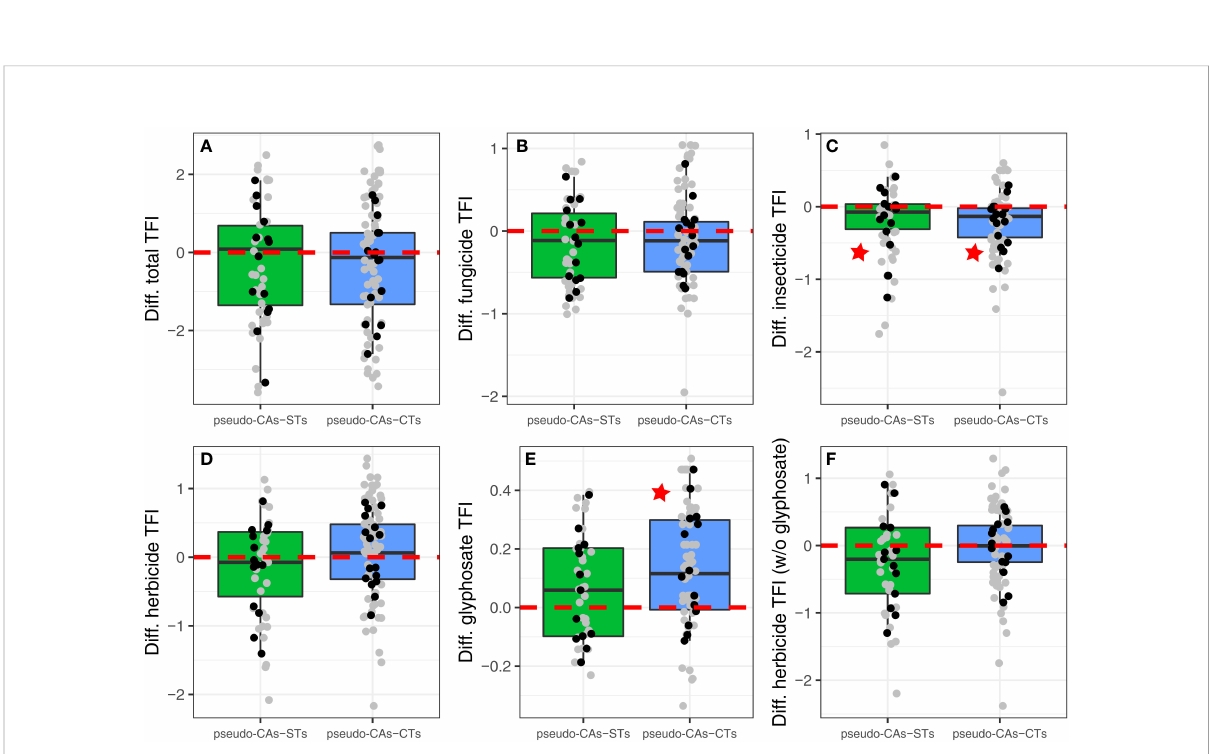
FIGURE 6 Pesticide use in pseudo-conservation agriculture (pseudo-CAs). Distributions of the differences in response variables between pseudo-CAs and their reference conventional tillage (CTs, blue boxplots) and super fi cial tillage (STs, green boxplots) based systems for: total treatment frequency index (total TFI including seed treatments, (A) , fungicide TFI (B) , insecticide TFI (C) , herbicide TFI (D) , glyphosate-based herbicide TFI (E) , and herbicide TFI without glyphosate (F) . The TFI are those computed with “ at the pest target ” method. Grey dots represent individual differences between systems. Black dots represent average differences per cluster. Red stars indicate signi fi cant differences between pseudo-CAs and its reference system (either CTs or STs) at p<0.05, cluster accounting for the production situation included as a random effect in the model (see details in Table